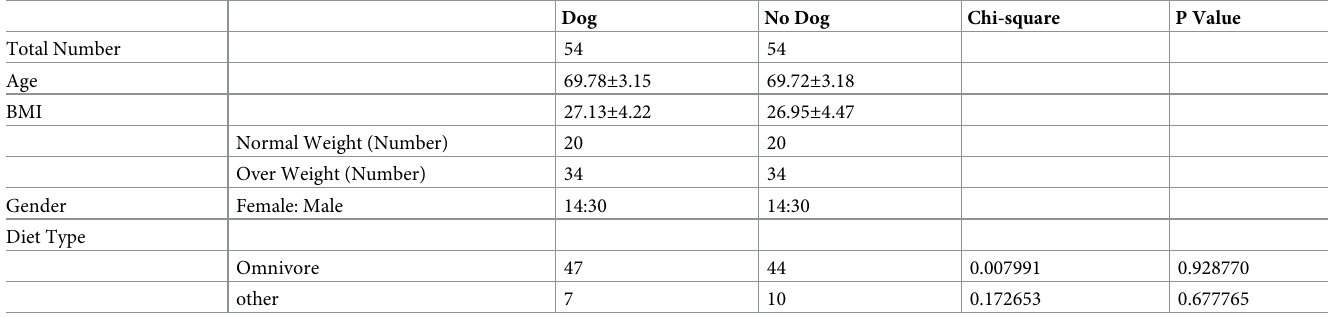
Table 1. Demographic and anthropometric characteristics of the elderly dog